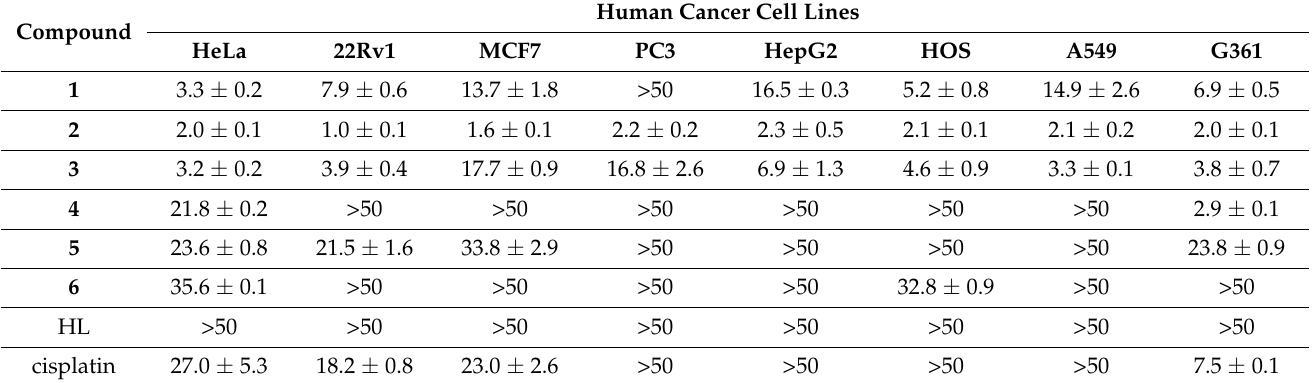
Table 4. The in vitro cytotoxicity of complexes 1–6 and the reference drug cisplatin after 24 h of incubation. The data are expressed as IC 50 ± SD ( µ M) calculated from the dose–response curves obtained from at least three independent